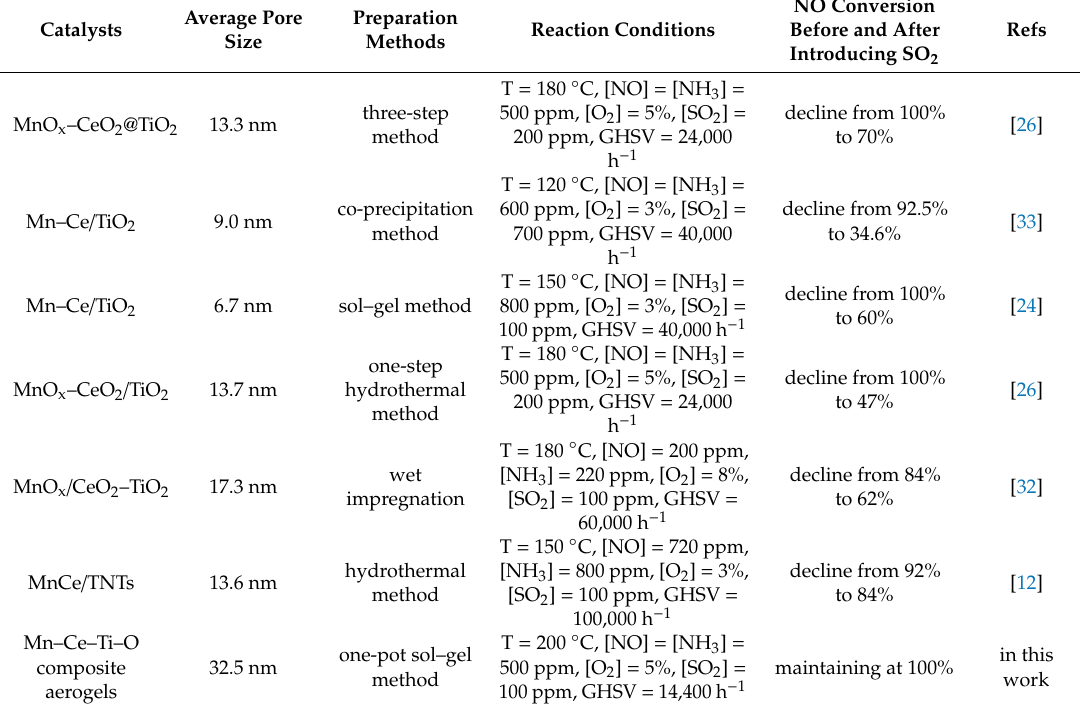
Table 4. A comparison of anti-SO 2 performance of MnO x –CeO 2 –TiO 2 catalysts prepared by di ff erent methods in the reported